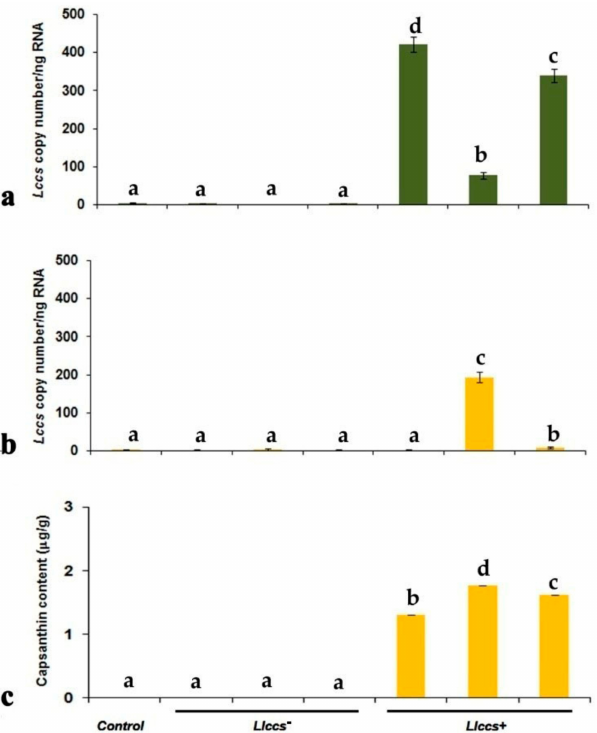
Figure 8. Absolute quantification of Llccs expression by qPCR in leaves ( a ) and flower petals ( b ) and capsanthin content in petals ( c ) of control and selected Llccs − and Llccs + V. cornuta plants. Both measurements were conducted with one control and three Llccs − (lines 30, 37 and 41) and Llccs + (lines 2, 3 and 7) plants. The qPCR quantifications were performed in three technical replicates; data represented the mean values ± standard errors, where the same letters indicate statistically homogenous groups based on the Fisher’s LSD test ( p ≤